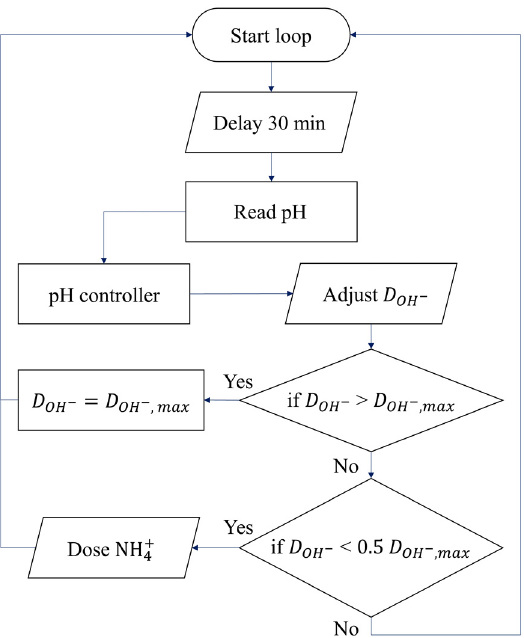
Figure 2. Sequential-Function-Chart of the batch control algorithm designed to infer ammonium extinction from a 50% reduction in the hydroxide dosing rate. The pH controller is a feedback-PI- controller. More specifically, hydroxide is constantly dosed to the system but the rate at which it is dosed is adjusted (increased/decreased) by the pH controller every 30 min. This adjustment is based on the error signal received by the controller (difference between the pH reading and the setpoint pH). Note that D OH − , max is the maximum D OH − value since the start of the run. To reduce experimental noise, a six-point running average of the dosing rates were used (average over 3 h) in the two “if” statements shown in the diamond boxes.